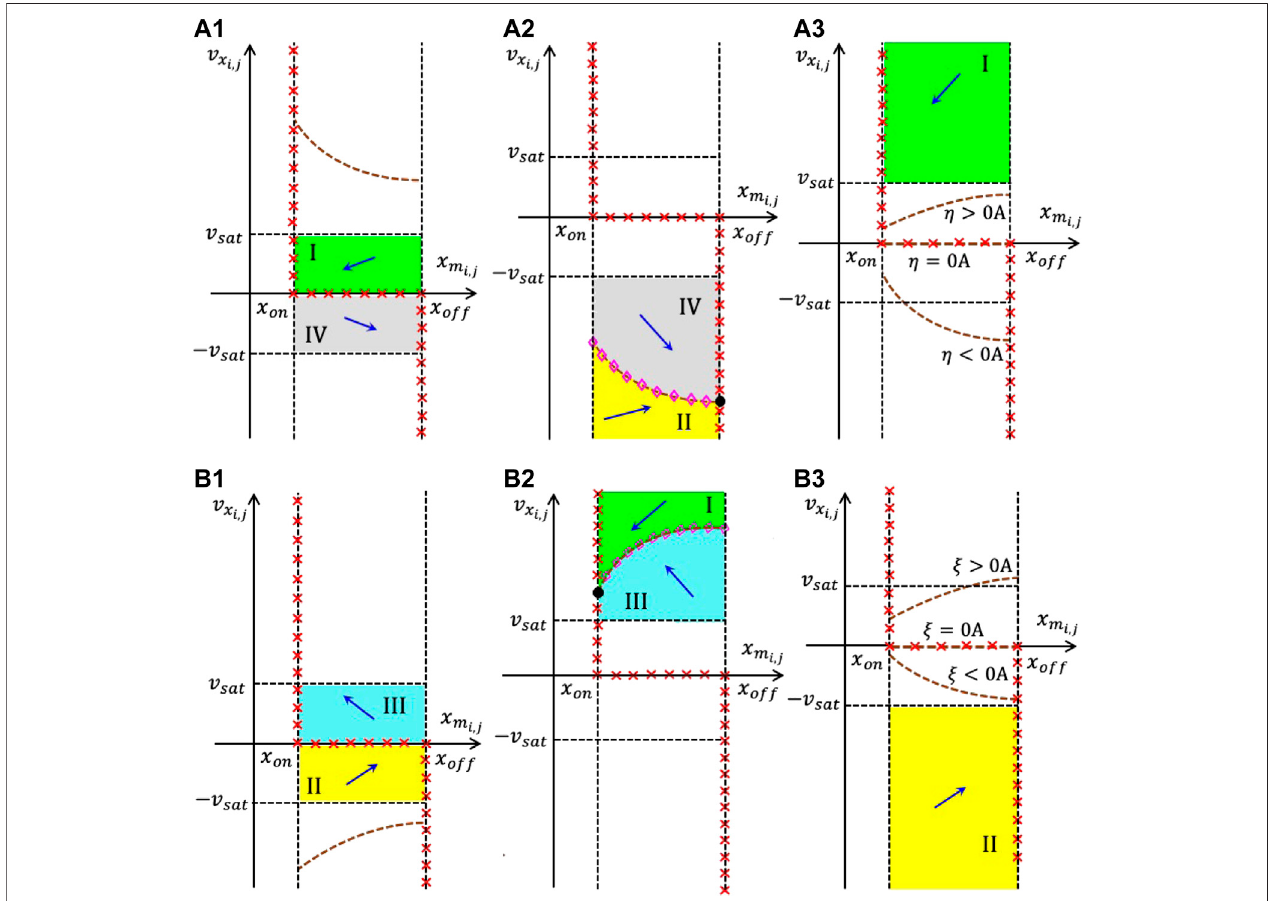
FIGURE15| QualitativevisualizationofthestrategyadoptedtomassagetheshapeofthecellDRM 2 intheEDGEaswellasintheSTOREM-CNNdesigns.Herethe stepwiseapplicationoftheproposedsystematicgenesynthesismethodologyinthelinearregion(a.1)((b.1)),inthenegative(positive)saturationregion(a.2)((b.2)),andin – v the positive (negative) saturation region (a.3) ((b.3)) of the phase plane x m x i , j enables to enforce the appearance of a single v x i , j nullcline, namely Eqs. 34 , 36 , and the i , j existence of one and only one equilibrium, speci fi cally Eqs. 39 , 45 , in the EDGE cell SDP, which emerges in each scenario of rule 1 and for rule 2 (under all circumstancesinrule3)from Table4 ,aswellasintheSTOREcellSDP,whichformsunderthehypothesisofrule1(2)from Table5 .Withreferencetothe fi rst(latter)set of scenarios, combining plots (a.1), (a.2), and (a.3) ((b.1), (b.2), and (b.3)) provides an ad-hoc cell SDP, given that the phase-plane partition guides all trajectories toward the unique equilibrium in the negative (positive) saturation region, as desired in the EDGE as well as in the STORE M-CNN designs. The dashed brown curve without (cid:1) v ( x ) characteristic,expressedby Eq.35 ,andconstrainedtolieintheregion v > ( < ) + (−) v magentadiamonds in(a.1)((b.1))isthe v x x i , j m i , j x i , j sat ,soastokeepthelinear i , j (cid:1) 0V · s − 1 , region free of v x nullclines. The dashed brown curve with magenta diamonds in (a.2) ((b.2)) represents the only locus of points of the phase plane, where _ v x i , j i , j (cid:1) v ( x ) as expressed by Eqs. 34 , 36 .Finally,theset ofthree dashed browncurveswithout magenta diamonds in(a.3) (b.3) constitute thepossible courses ofthe v x x i , j m i , j i , j _ v < ( > ) + (−) v (cid:1) 0V · s − 1 loci, characteristic, expressed by Eqs. 34 , 36 , constrained to lie in the region v x sat , so as to keep the positive (negative) region free of x i , j i , j depending upon the sign of η b i